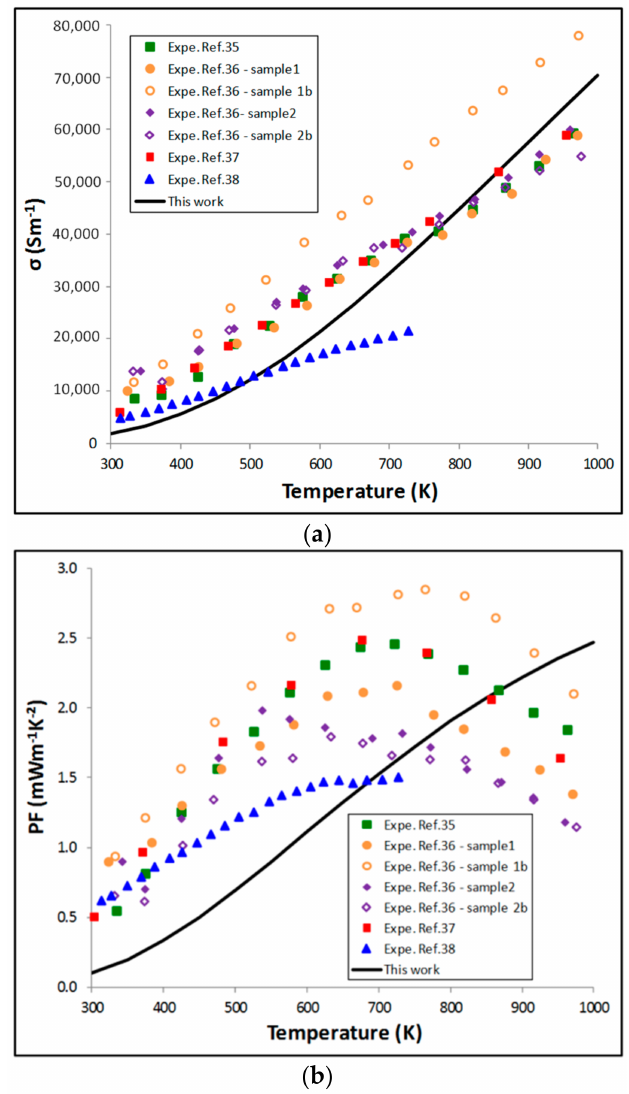
Figure 6. Effect of temperature on: ( a ) Electrical conductivity; ( b ) power factor ( PF ) calculated using BoltzTraP compared to a selection of experimental